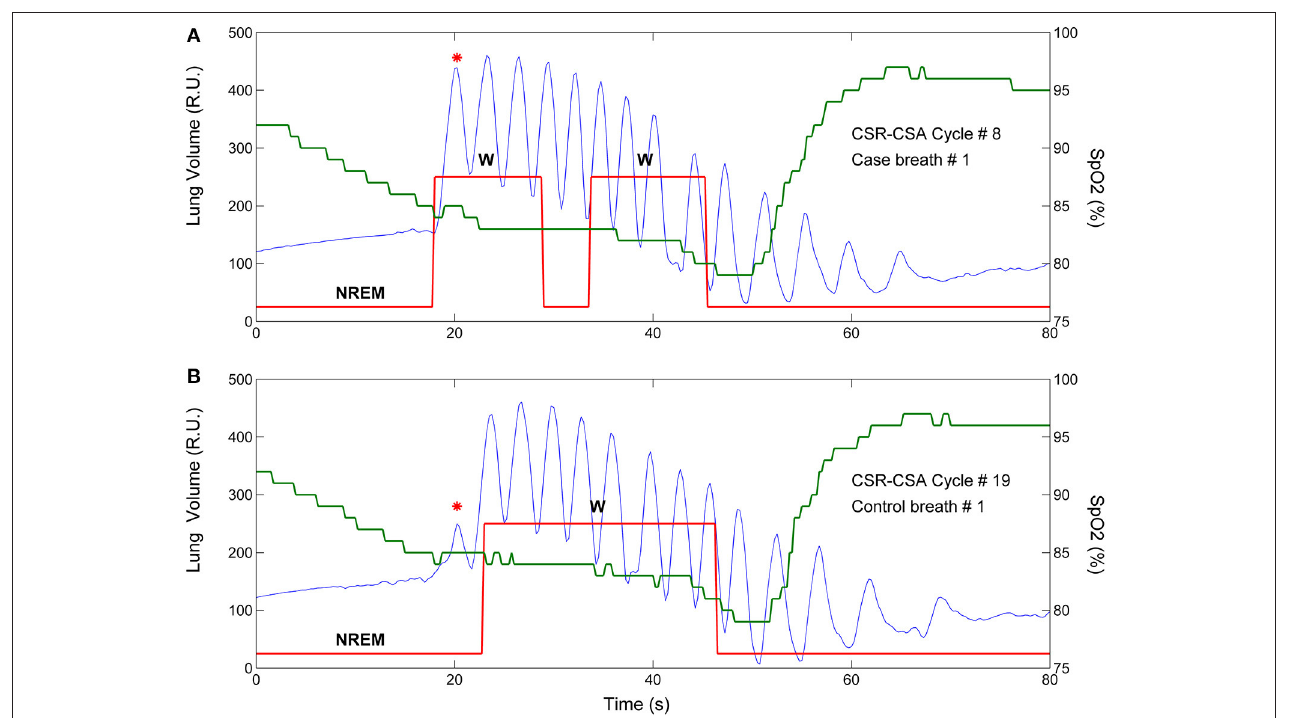
FIGURE 1 | Example of breath-by breath case-control matching in the assessment of the relationship between arousals and ventilation. Blue solid line: lung volume; red solid line: state-transition diagram providing continuous information (resolution: 250ms) on the sleep-wake state of the subject [stage 1, 2 non-rapid eye movement (NREM) sleep or wakefulness (W)] ( 4); green solid line: estimated oxygen saturation (SpO 2 ) at carotid chemoreceptors. (A) An arousal occurred during the hyperpneic phase of the 8 th CSR-CSA cycle, potentially affecting several breaths (case breaths). A short ( ≈ 5s) transition to NREM sleep during the arousal can also be noticed. (B) A matched control breath for the first case breath was found in the 19 th CSR-CSA cycle (closest cycle). This case-control pair is indicated by an asterisk. By definition, the two breaths had similar mean SpO 2 (84.5 vs. 85.0%), similar duration of the hyperpneic phase (48 vs. 51s) and same sleep stage (N2). RU, relative